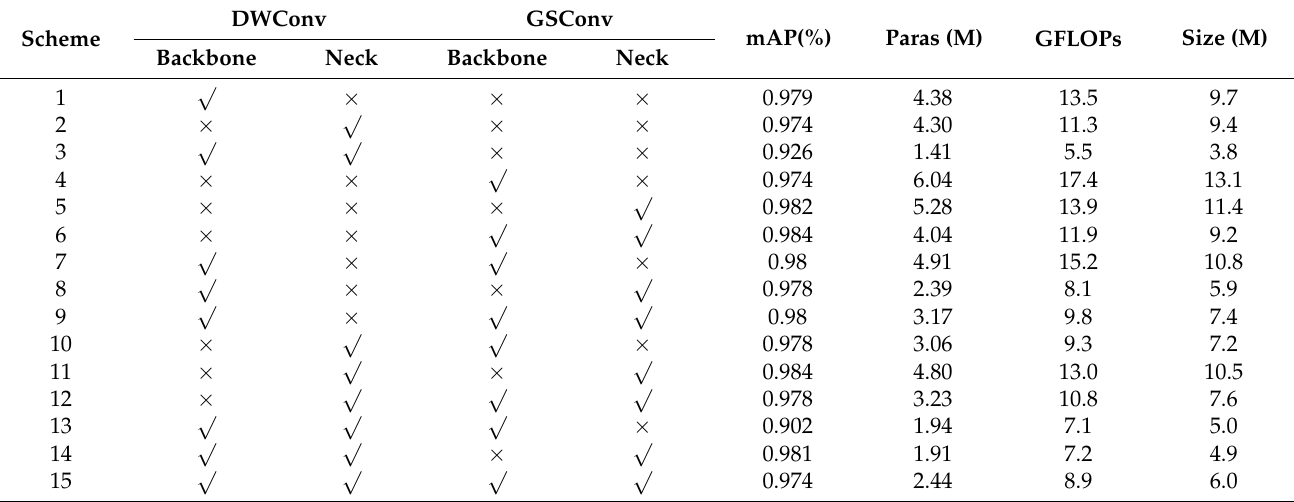
Table 4. Comparison of different lightweight schemes.